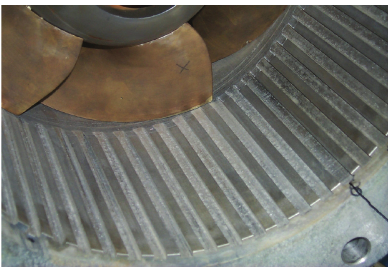
Figure 1: Flat axial grooves in front of the rotor used by Goltz [6].